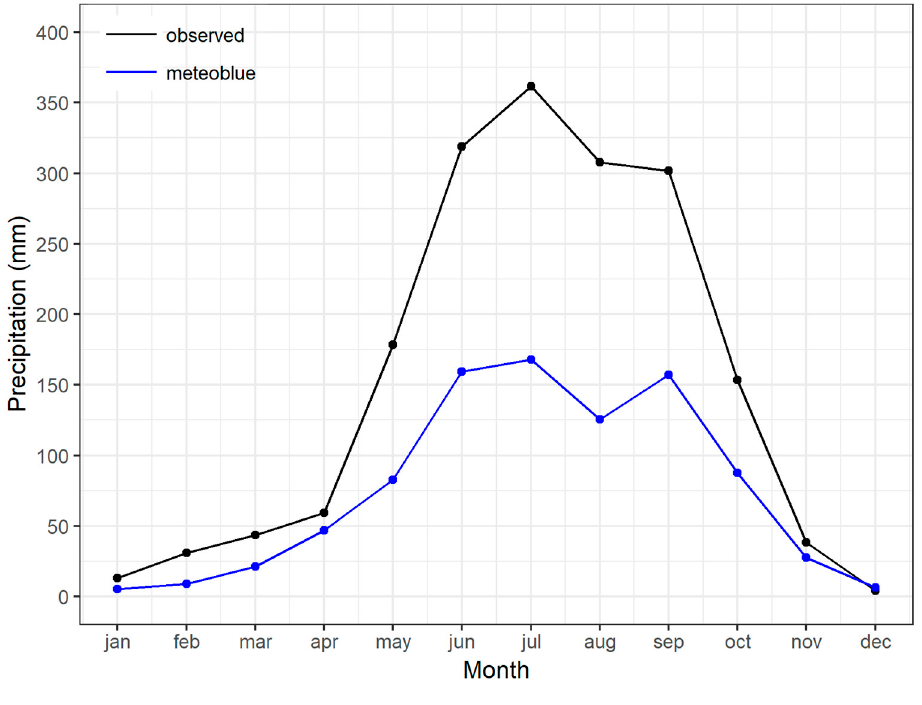
Figure 5. Mean monthly climatology for the period 1981–2016 of the meteoblue hindcast with observations for Khulna station.